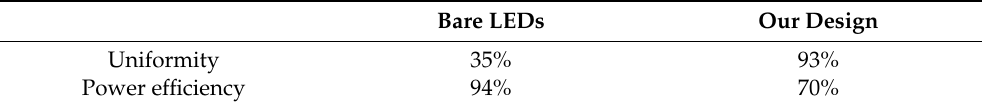
Table 2. The comparison chart for different methodologies. Methodology